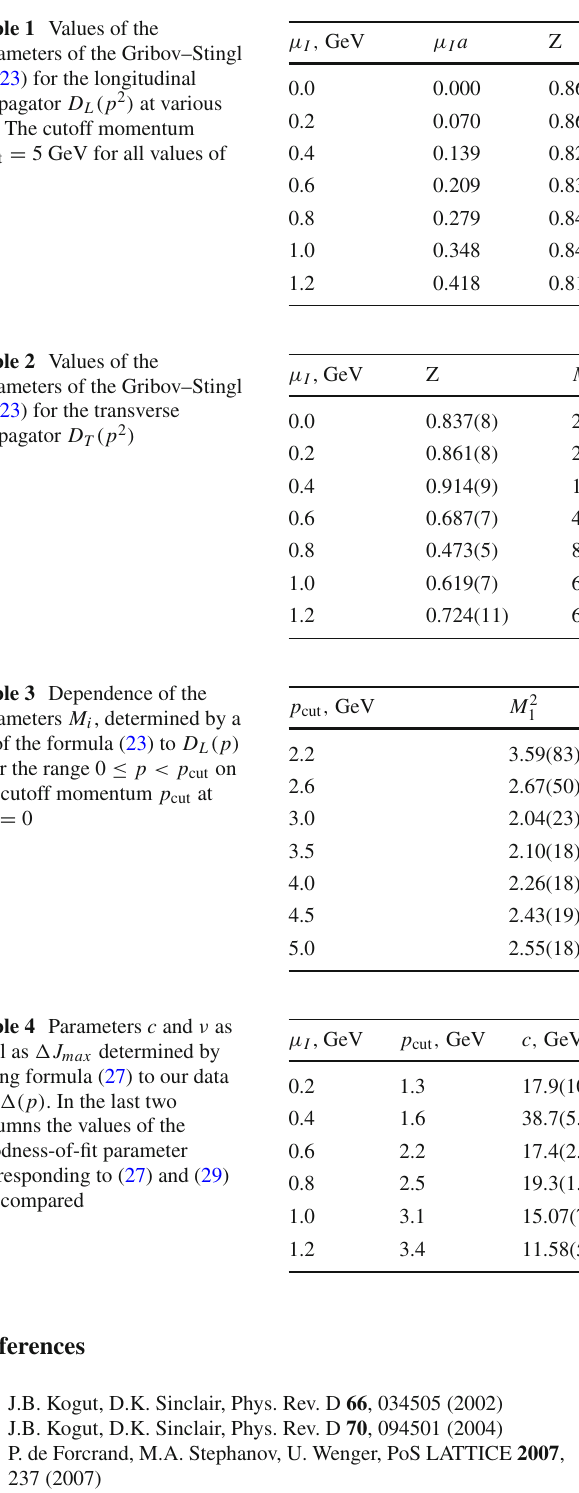
parameters of the Gribov–Stingl fit (23) for the longitudinal propagator D L ( p 2 ) at various μ I . The cutoff momentum p cut = 5 GeV for all values of